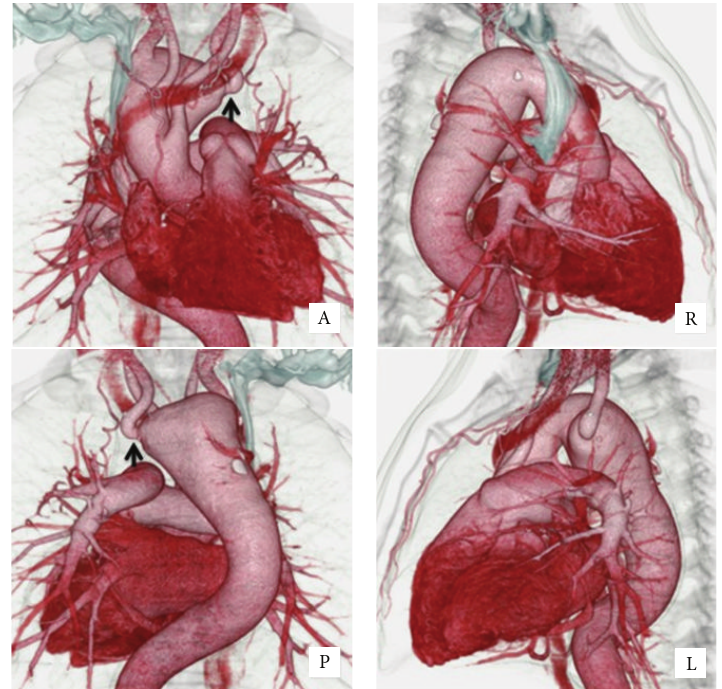
Figure 1: Enhanced CT showed right aortic arch, Kommerell diverticulum, and aberrant left subclavian artery. There was a 50% stenosis of the orifice of aberrant left subclavian artery (arrows).